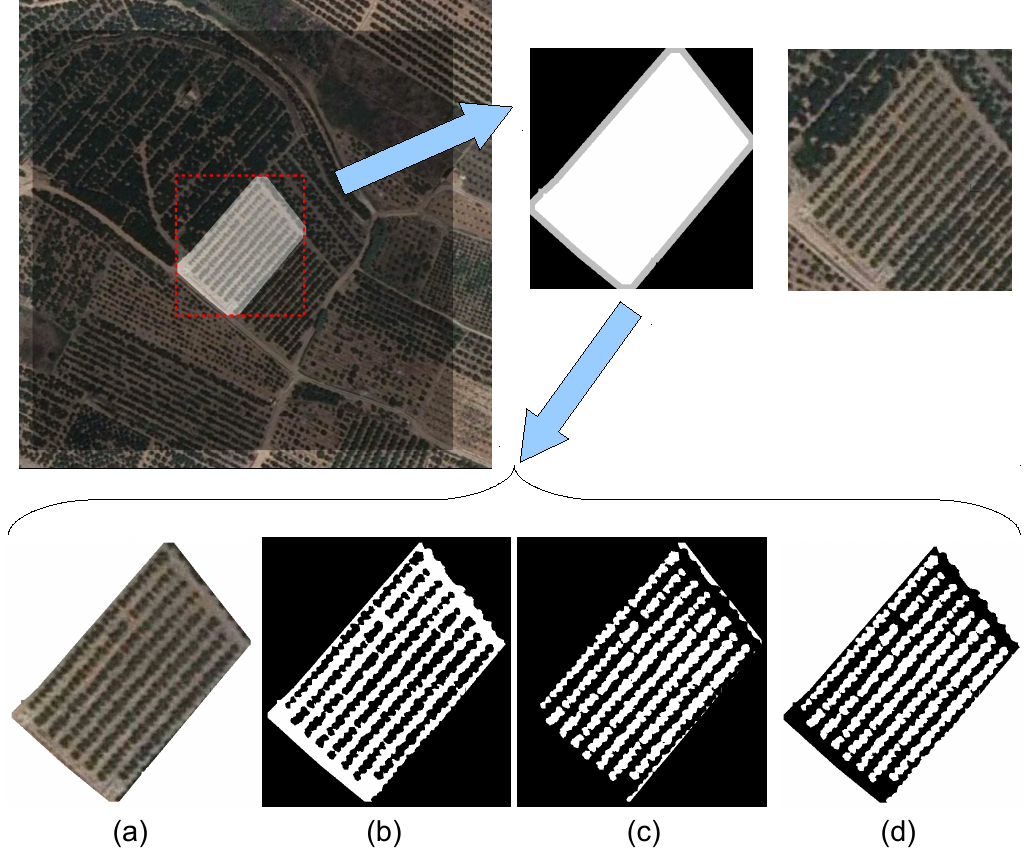
Figure 5. Generating binary maps from the satellite maps. ( a ) satellite view of the current parcel, ( b ) Path image of the current parcel, ( c ) Trees image of the current parcel, ( d ) Obstacles image of the current